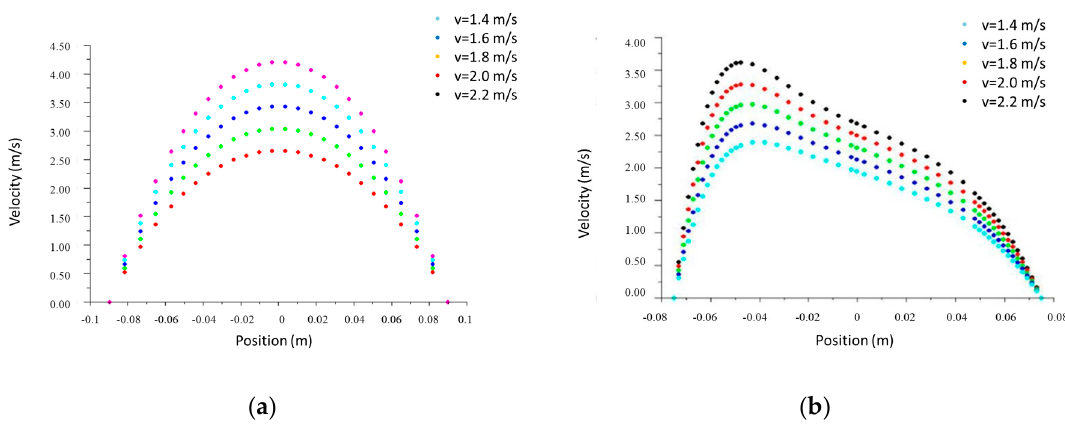
Figure 8. The velocity distribution profiles on the same cross-section of the CGFB slurry along the horizontal pipe at different axial positions: ( a ) velocity profile on the straight pipe; ( b ) velocity profile on the 90° elbow pipe.